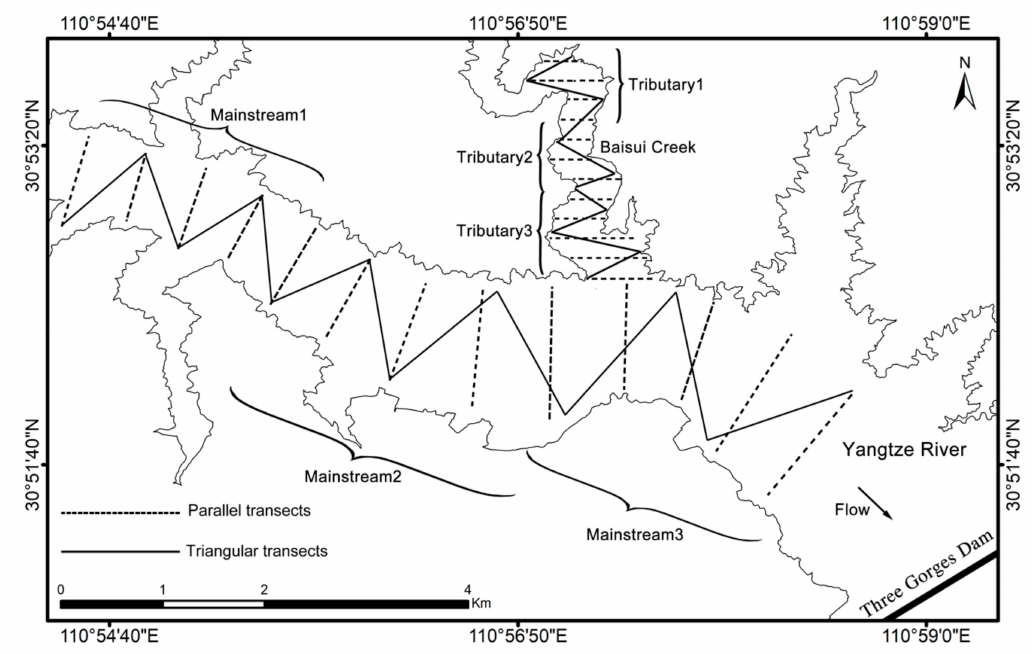
Figure 1. Study area in the Three Gorges Reservoir, China, showing the two types of hydroacoustic survey transects designed in the Yangtze River mainstream and the adjacent